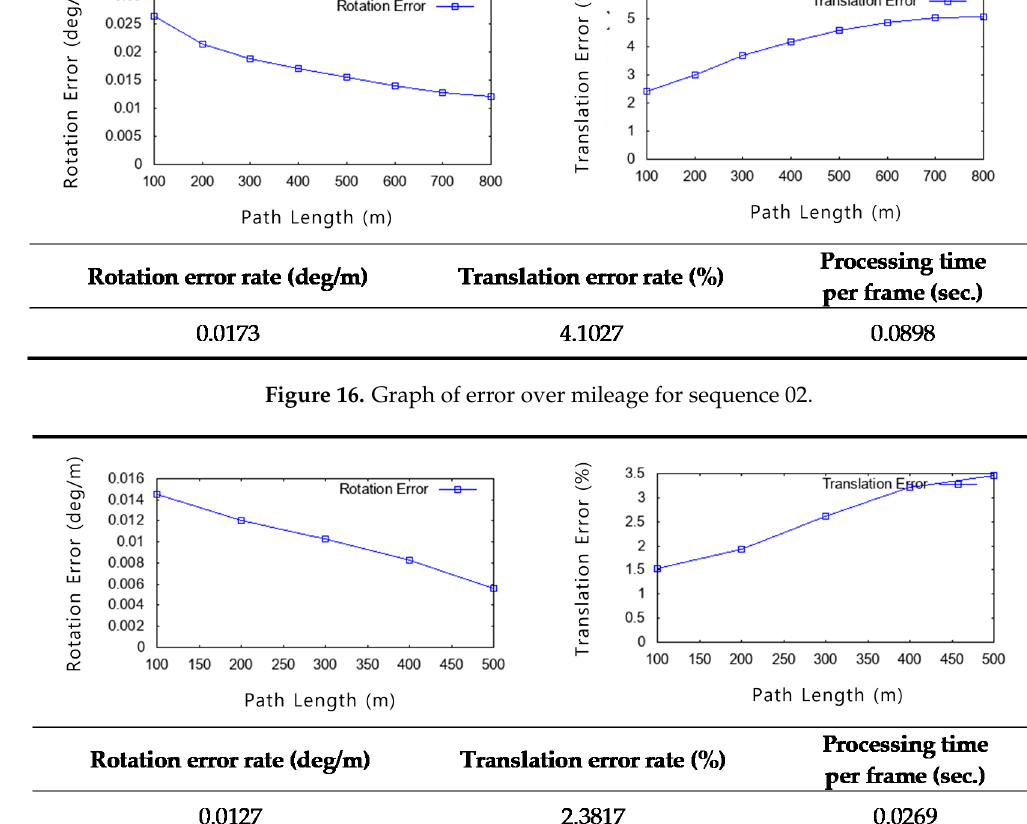
Figure 18. Graph of error over mileage for sequence 04. Figure 19. Graph of error over mileage for sequence 05.